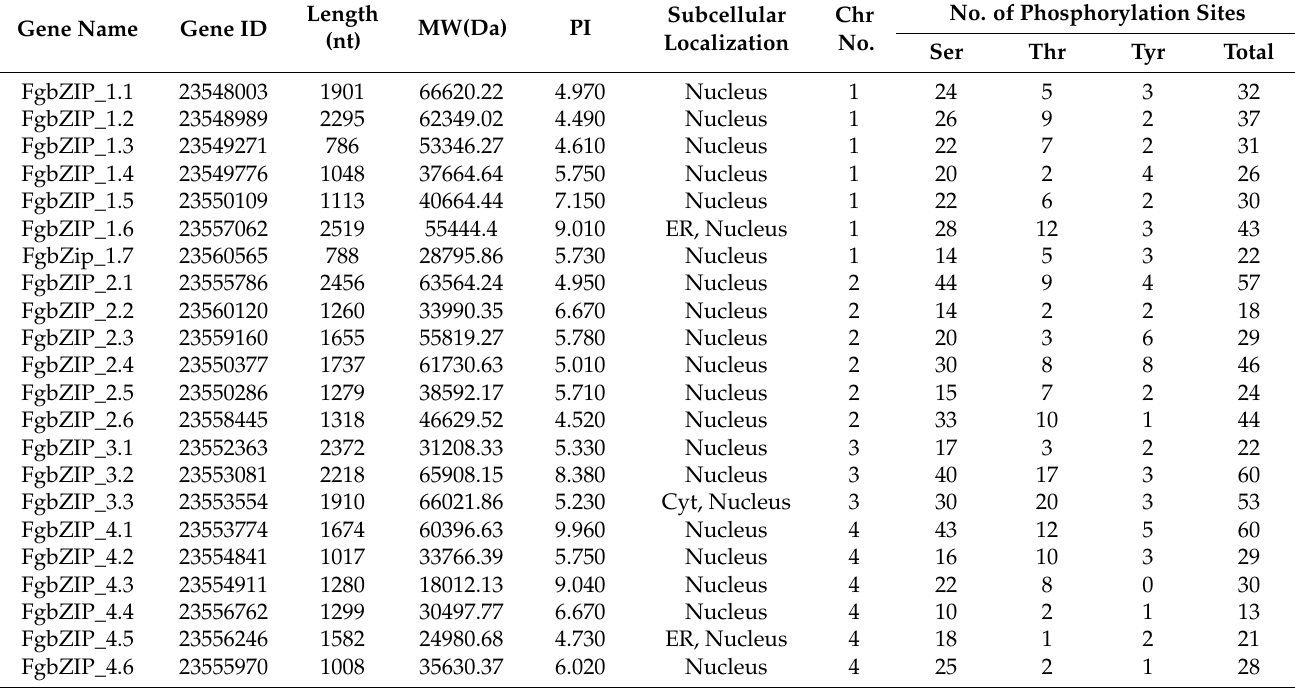
Table 1. Characteristics of bZIP gene family in F. graminearum